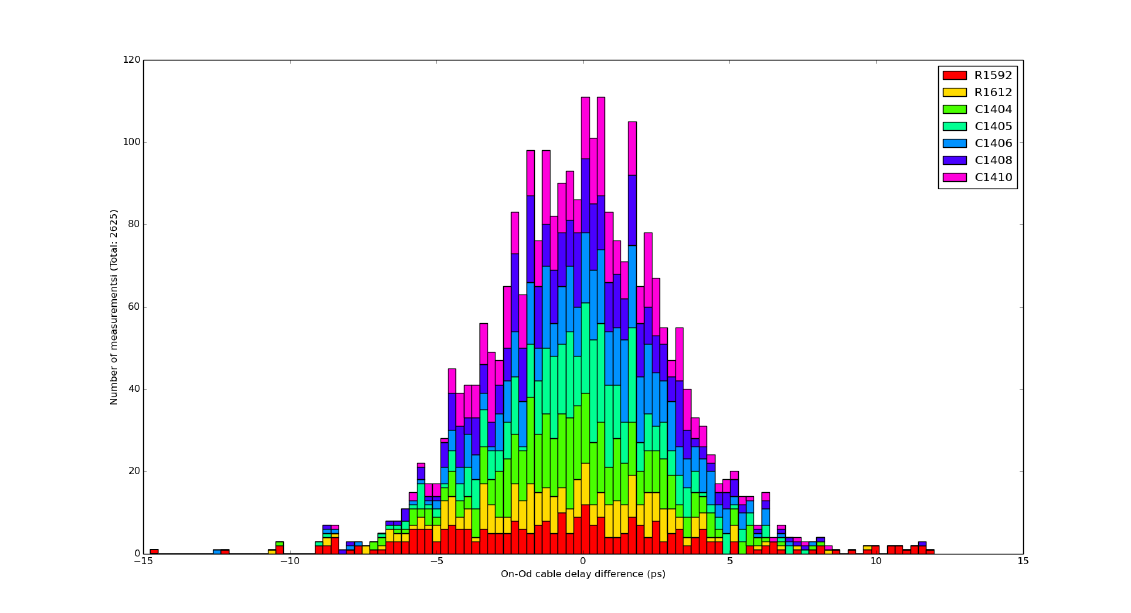
Figure 5: Differences between the cable calibration data for On and Od that were recorded in the respective log files for seven sessions.